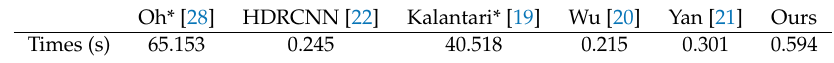
Table 5. Run time (in seconds) for different methods averaged on test images [19], where ‘*’ denotes the methods using CPU. Other methods are tested under GPU